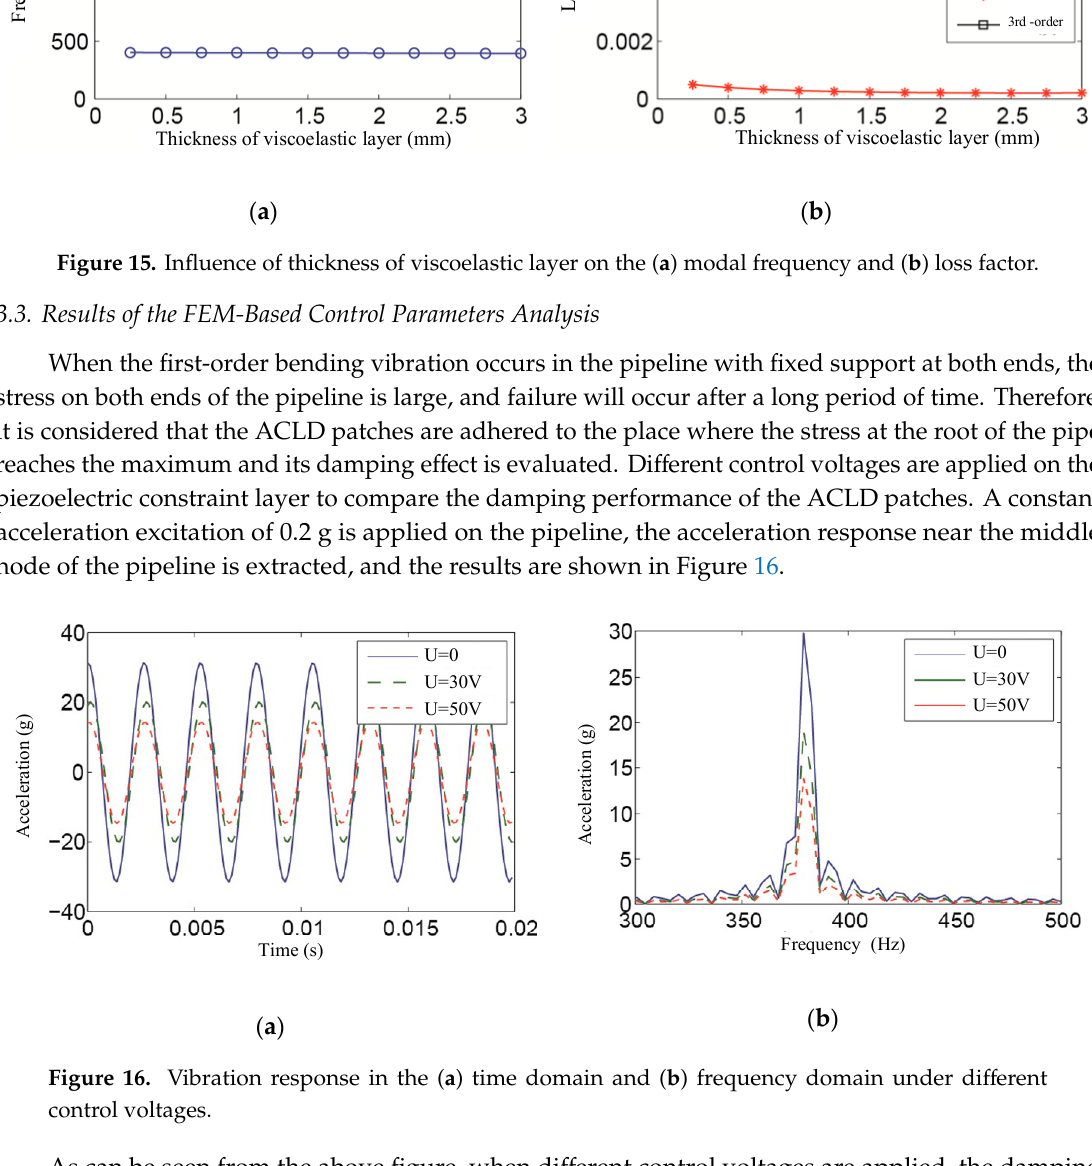
Table 5. Amplitude of acceleration response under different control voltages.